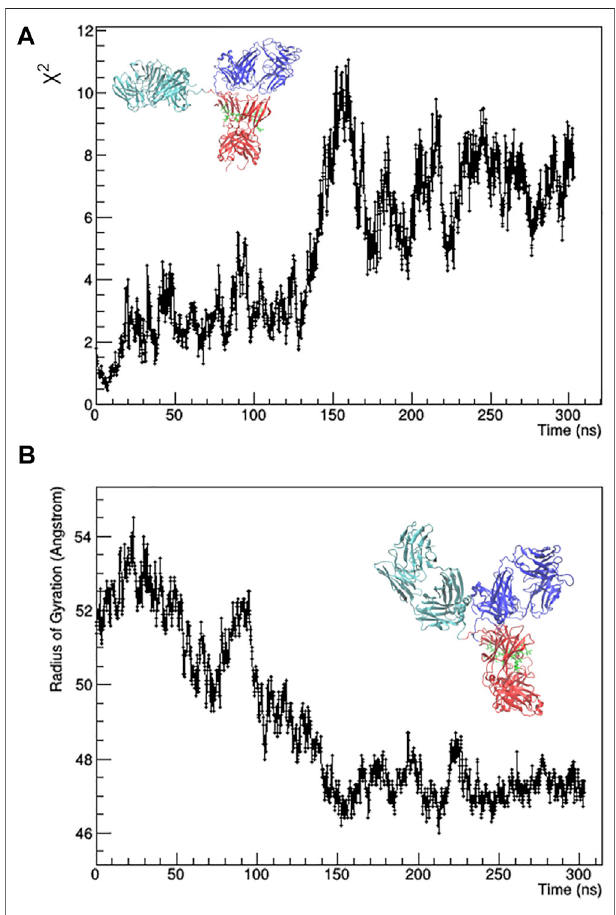
FIGURE 2 | Results of the unrestrained molecular dynamics. χ 2 value of the fi t between calculated and observed SAXS pro fi le (A) and radius of gyration (B) as a function of the simulation time. The best fi tting model (on the left) and the fi nalone(ontheright)areshown.Fa,Fband Fcdomains are coloured in cyan, blue and red, respectively. Glycans are coloured in green and put in licorice